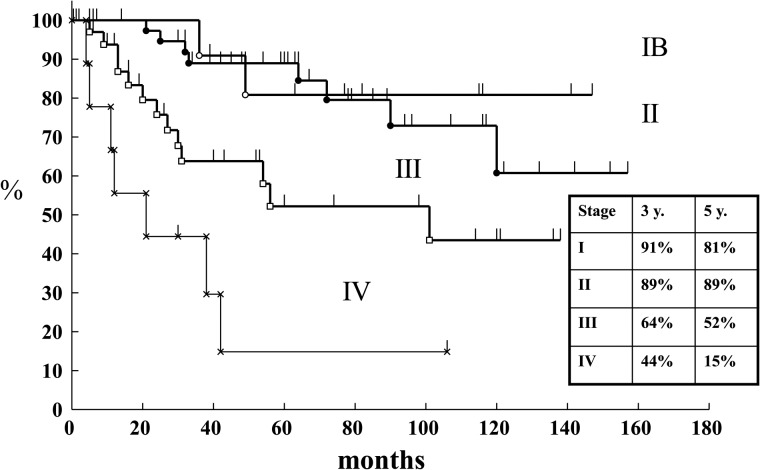
Cause-specific survival of carcinoma of the uterine cervix by stage (Arm A: June 1998–January 2004).